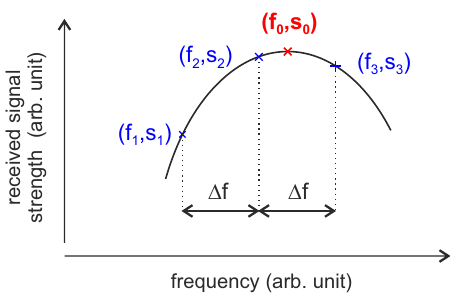
Figure 13. Pulsed FM/AM tracking loops with three-point interrogation